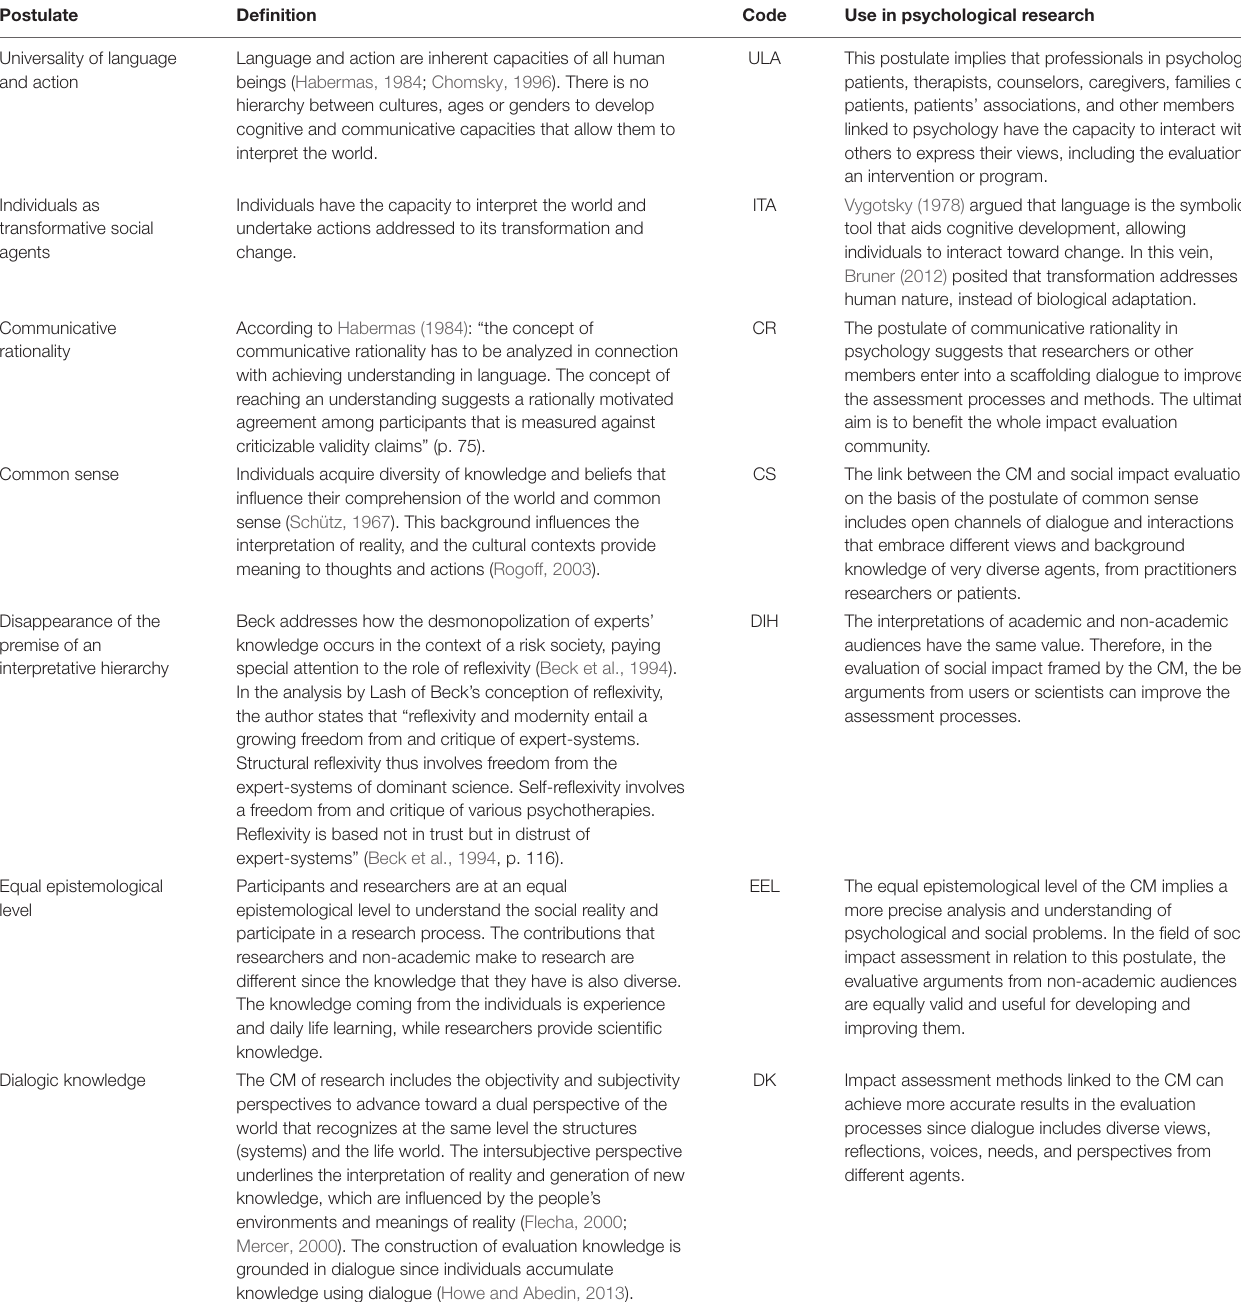
TABLE 1 | Coding scheme drawing on the seven postulates of the communicative